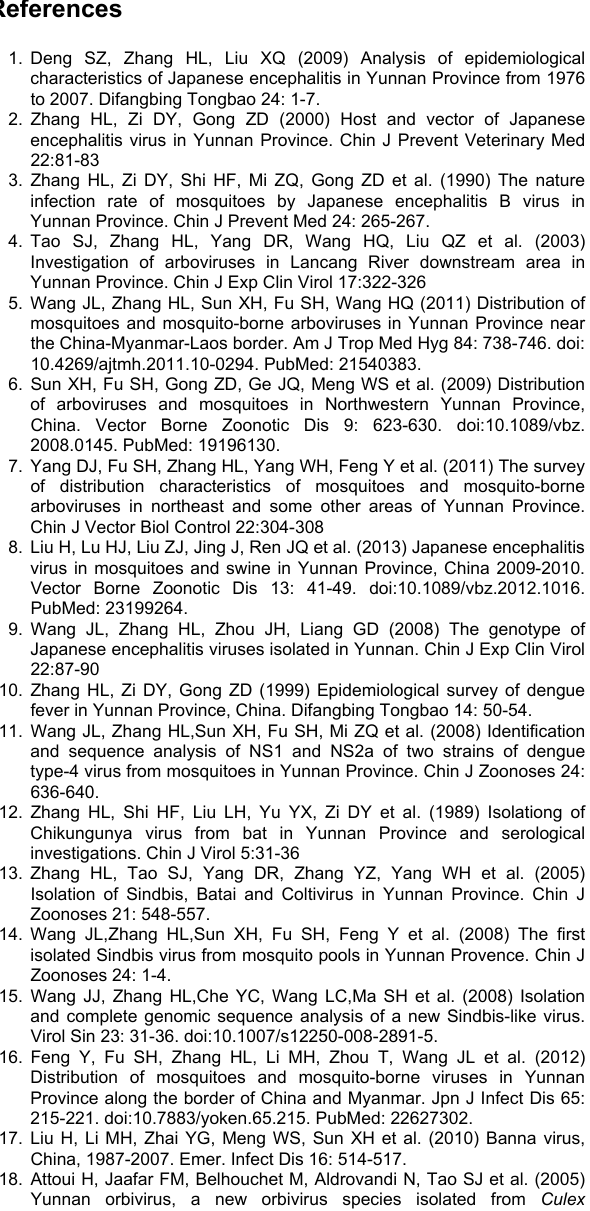
Table S3. The results of Z-test for comparing the collected number of each common species between Mangshi and